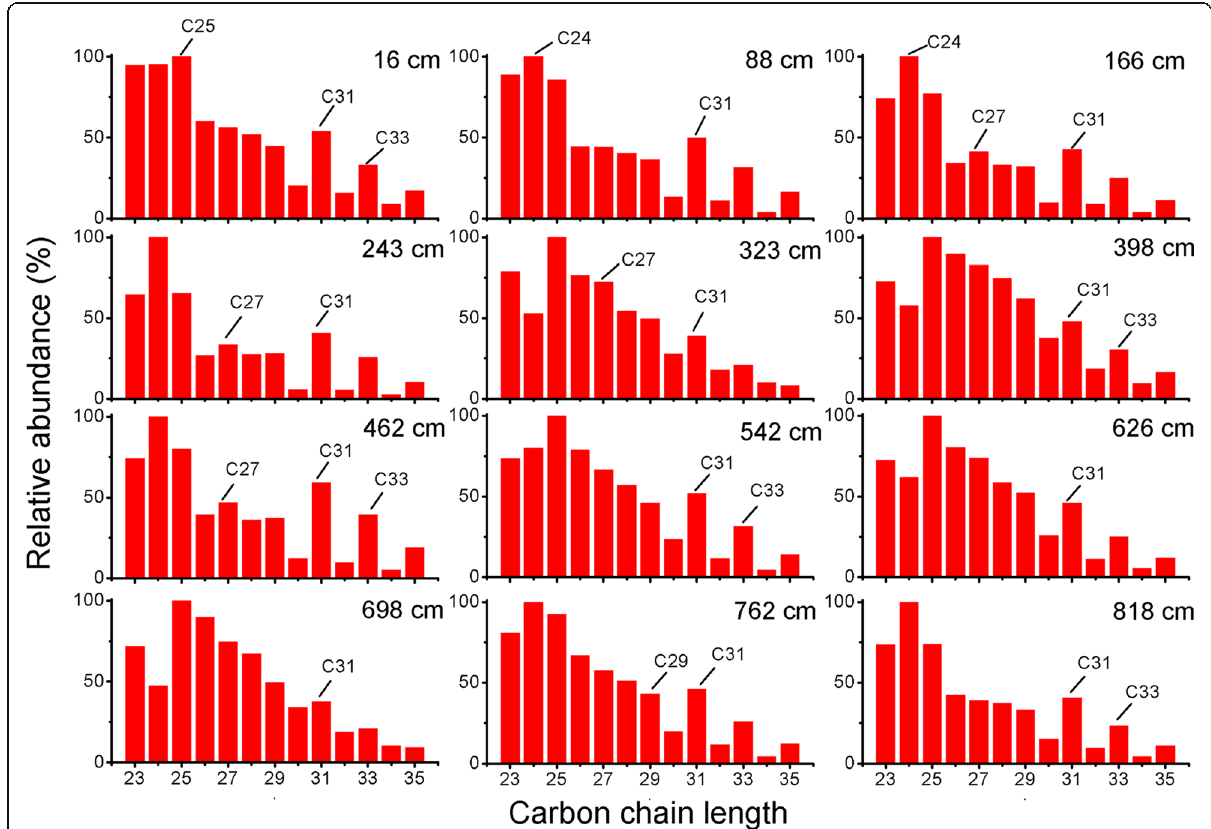
Fig. 3 The relative abundance of long chain n -alkanes (C 23 – C 35 ) at different depths of the core R23